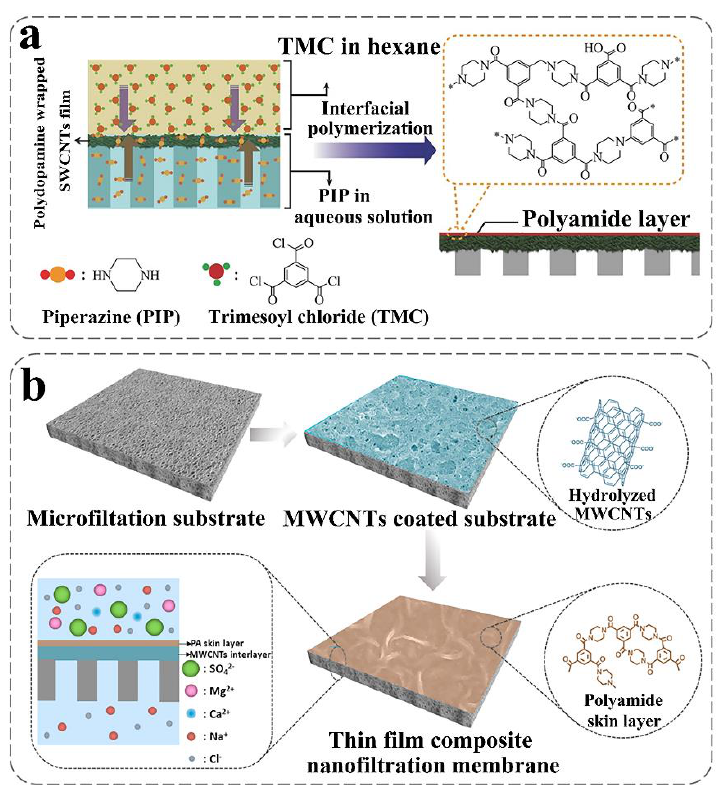
Figure 6. Preparation of composited CNT membranes. Schematic diagram of ( a ) interfacial polymerization process for the preparation of PD/SWCNTs film supported ultrathin PA NF membrane (Reproduced or adapted from ref. [118], with permission from Wiley–VCH Verlag, (Weinheim, Germany), 2016); ( b ) TFC membranes combining CNT intermediate layer and microfiltration support with high NF properties (reproduced or adapted from ref. [103], with permission from Elsevier,